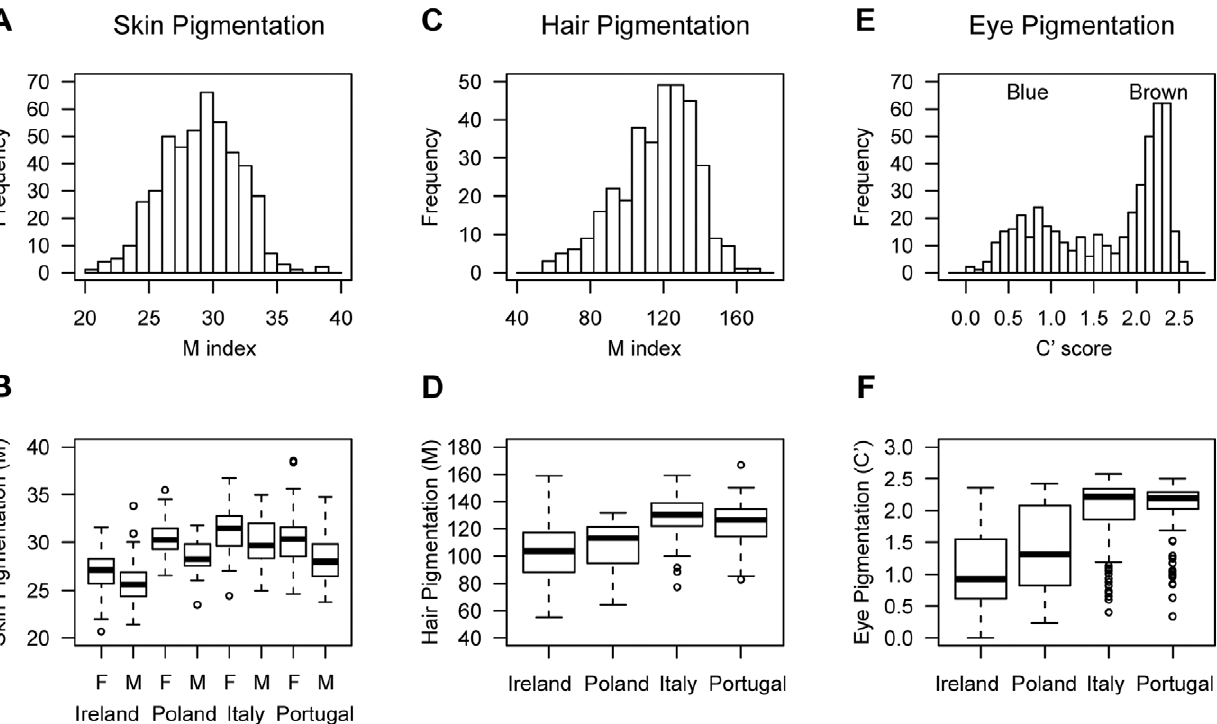
Figure 1. Distribution of skin, hair, and eye pigmentation. Skin pigmentation histogram ( A ) and boxplot by country of sampling and sex ( B ) in 469 individuals showing the normality of the phenotype distribution and the differences between sexes and among countries. Males (M) have consistently lighter pigmentation (lower scored) than females (F) in all four countries. Among countries, the largest pigmentation difference is with Ireland, where, in our sample, individuals have lighter pigmentation or lower M index on average than in Poland, Italy, or Portugal. Hair pigmentation histogram ( C ) and boxplot by country ( D ) in 341 individuals showing the distribution of hair pigmentation and the differences among countries. In our sample, individuals from Northern European countries (Ireland, Poland) have on average lighter hair pigmentation than individuals from Southern European countries (Italy, Portugal). The distributions in males are similar to those in females in all countries except Ireland, where, in our sample, males have darker hair color than females (not shown). Eye pigmentation histogram ( E ) and boxplot by country ( F ) in 468 individuals showing the bimodal distribution of eye pigmentation and the differences among countries. Comparison with self-reported phenotypes shows that the two modes of the distribution correspond to blue and brown eye color, while individuals reporting green and hazel eye color have intermediate C’ values. As with hair pigmentation, in our sample, individuals from Northern European countries have on average lighter eye pigmentation than individuals from Southern European countries. r= 0.18, p = 7 6 10 2 4 ) are still correlated in the four populations combined, after adjusting for both country and sex. Within each country the results are variable. Skin and eye pigmentation are correlated in Ireland. Hair and eye pigmentation are correlated in Portugal. Skin and hair pigmentation are correlated in Poland and Italy (Table S2).